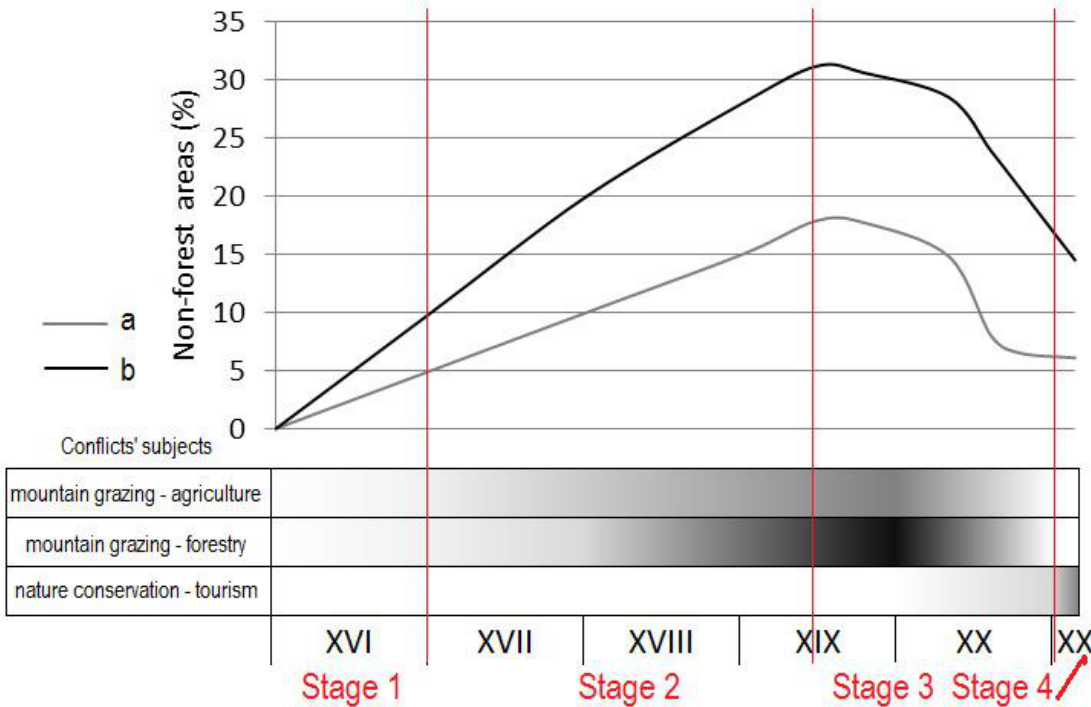
Fig. 8. A diagram of the correlation of landscape evolution stages with conflict sources (source: author’s own elaboration) a – the Wiślańskie mountain range, b – the Raczańskie mountain range. Non-forested areas percentage interpreted on the basis of source materials. Colour intensity in the bars relates to the intensity of the conflicts between mountain grazing (nowadays also nature conservation) and other types of landscape